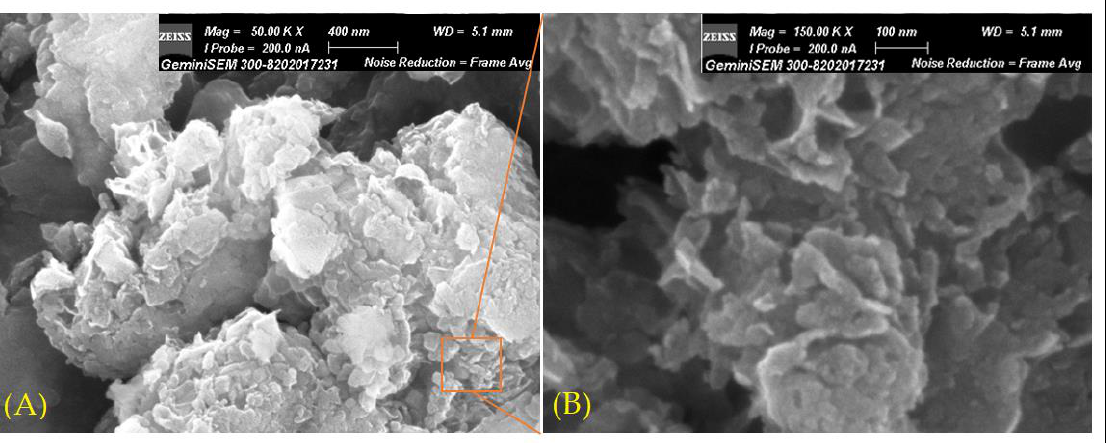
carbon nitride in the composite, MoS 2 predominates.